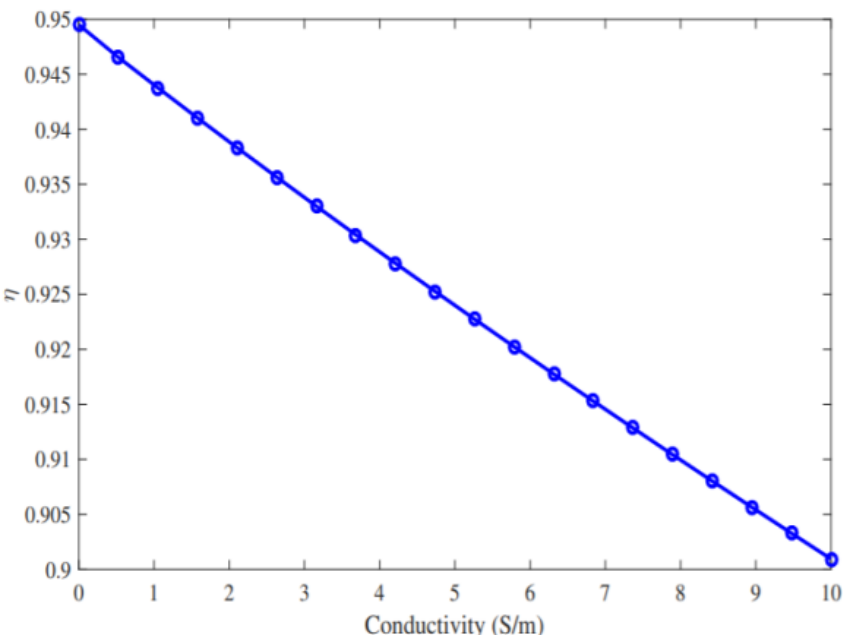
Figure 15. Water conductivity effect on efficiency.